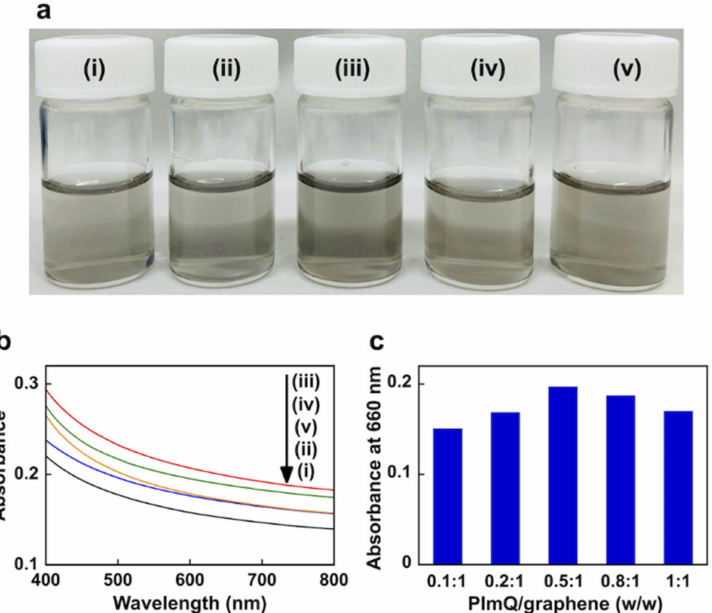
Figure 2. ( a ) Photographs of aqueous exfoliated graphene suspensions with different concentrations of PImQ. ( b ) Absorption spectra of PImQ/graphene suspensions in water. ( c ) Comparison of absorbance at 660 nm for each ratio of PImQ/graphene. PImQ/graphene = (i) 0.1:1 ( w/w ), (ii) 0.2:1 ( w/w ), (iii) 0.5:1 ( w/w ), (iv) 0.8:1 ( w/w ), (v) 1:1 ( w/w